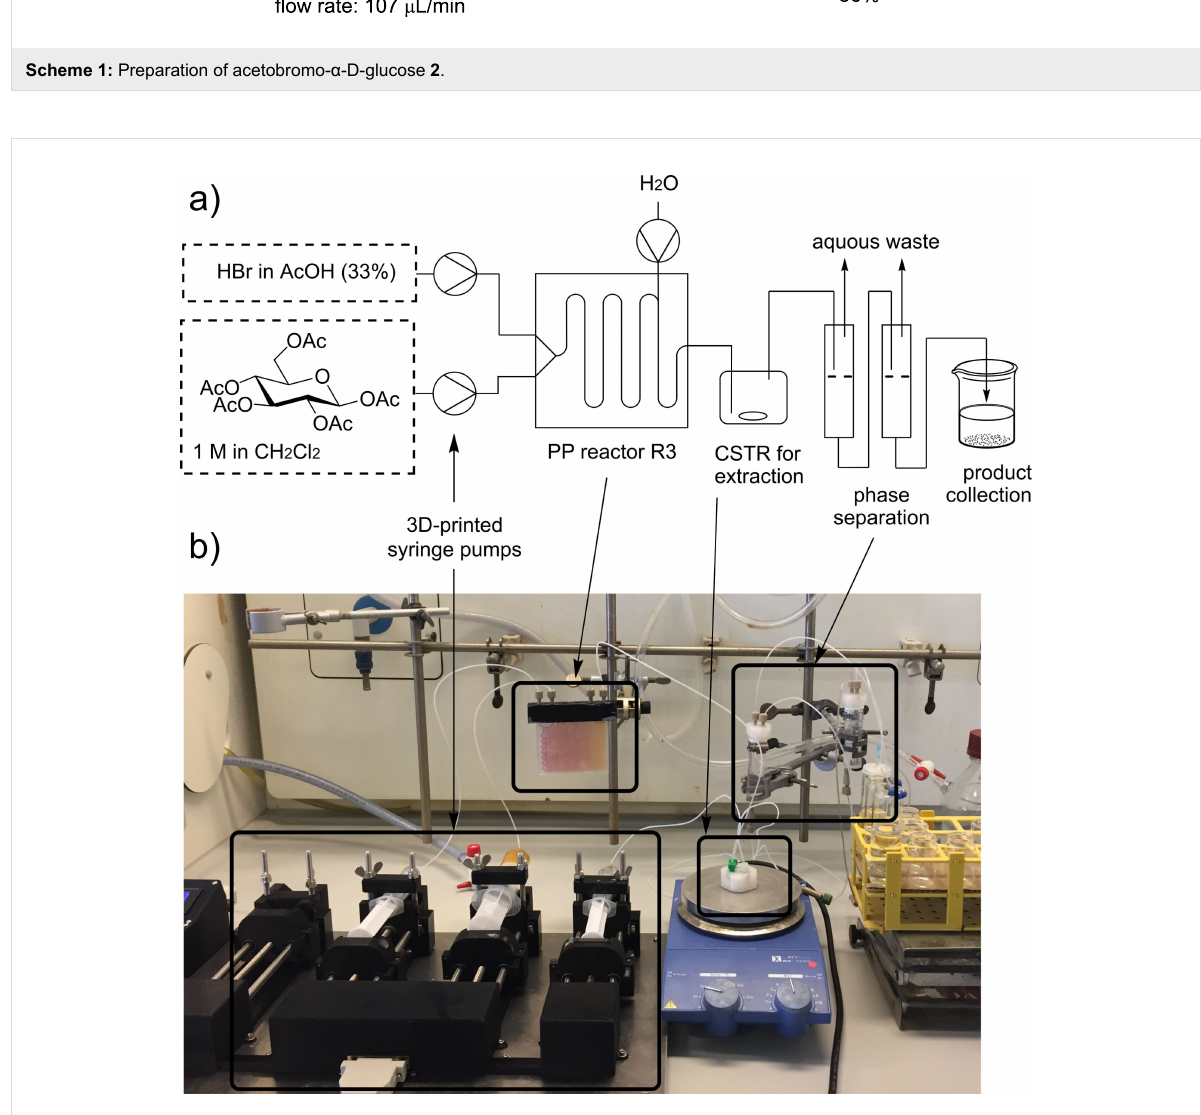
Figure 6: a) Schematic diagram for the continuous-flow synthesis of acetobromo- α -D-glucose 2 . b) Photograph of a typical setting for continuous flow reaction.